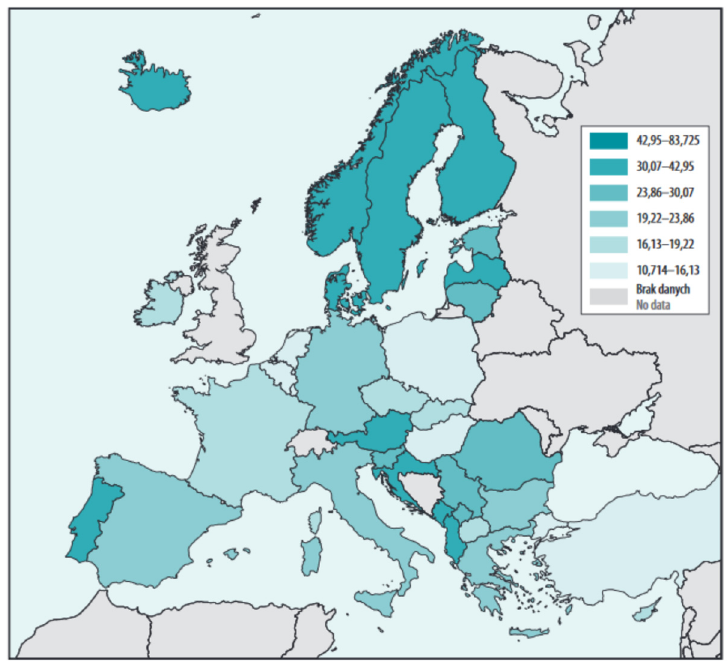
Figure 1. Share of renewable energy in final gross energy consumption in 2020. Source: https://ec.europa.eu/eurostat/web/products-datasets/-/sdg_07_40, accessed on 10 January 2023.